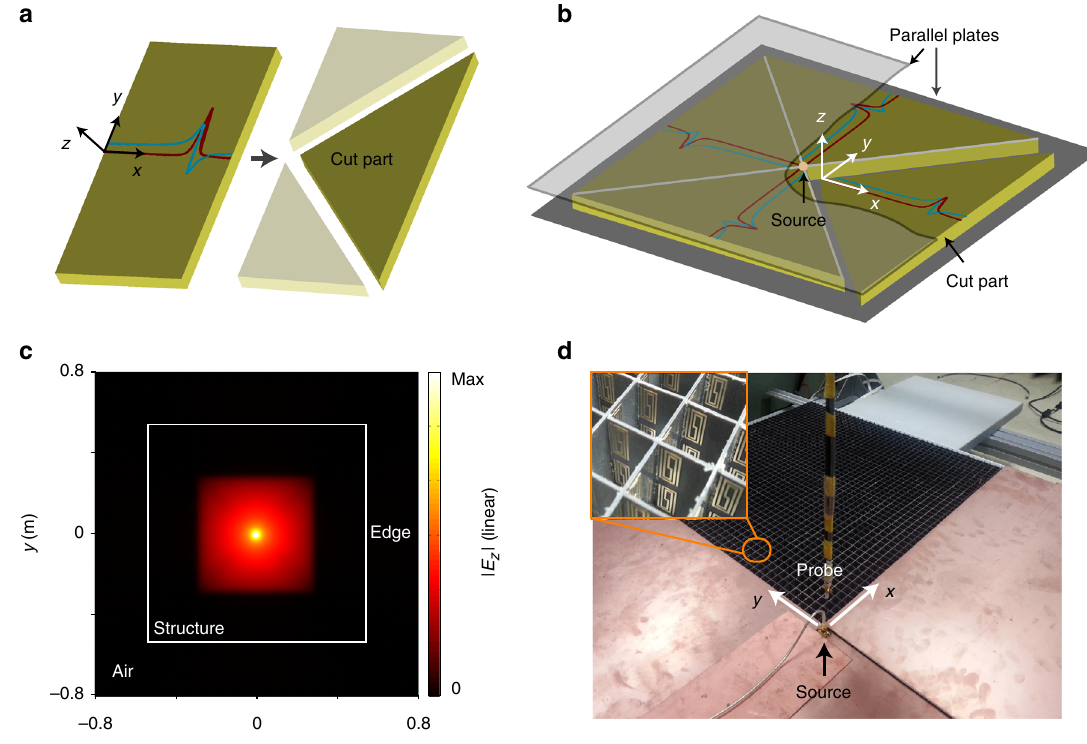
Fig. 5 Fabrication of the one-dimensional inhomogeneous sample and experimental setup. a Cutting off an isosceles right-triangle part from the original rectangular plate consisting of 2 × 91 × 182 unit cells. The real ( blue line ) and imaginary ( red line ) parts of the inhomogeneous permittivity of the cut part satisfy the designed Kramers – Kronig (K – K) pro fi le along the x direction. b Reassembling of four identical cut plates into a larger symmetric square plate. Seen from the origin, the real ( blue lines ) and imaginary ( red lines ) parts of the inhomogeneous permittivity satisfy the same K – K pro fi le along the x , y , – x , and – y directions, respectively. This plate is then sandwiched by two parallel copper-plated boards so that only a transverse electromagnetic mode can exist in the plate. Both boards are slightly larger than the plate. c Full-wave simulation of the sample shown in b at 2.4 GHz when the radiative source is placed in the center of the square plate. In the model, a free space boundary was used at the cutting edge, and a perfectly matched layer (PML) boundary was used to enclose the entire simulation region. d Photograph of the actual experimental setup. A small monopole probe with omnidirectional radiation is placed at the center of the square plate. Another identical monopole is sequentially placed in each cell to measure the amplitude and phase of